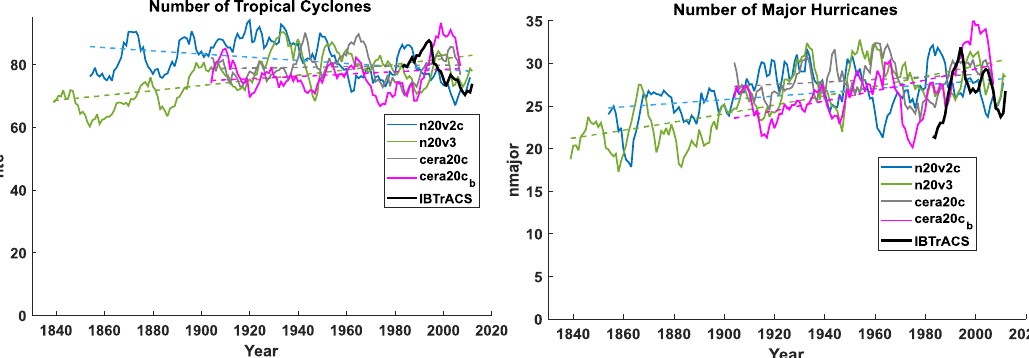
Fig. 3 Global annual numbers of tropical cyclones and major hurricanes from the IBTrACS historical data and downscaled from the three reanalyses. Global tropical cyclone count shown at left and major hurricanes at right; reanalyses used are indicated in the legends. Downscaling from a second ensemble member of CERA-20c is also shown here by the magenta curves, and the historical data are shown by the thicker black curves. Dashed curves show the Poisson regressions for each reanalysis